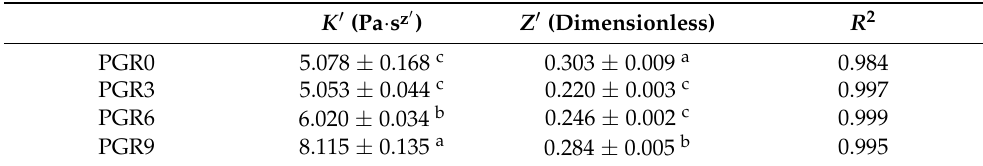
Table 1. Parameters of the functions describing viscoelastic properties of dough with different addition amounts of PGR